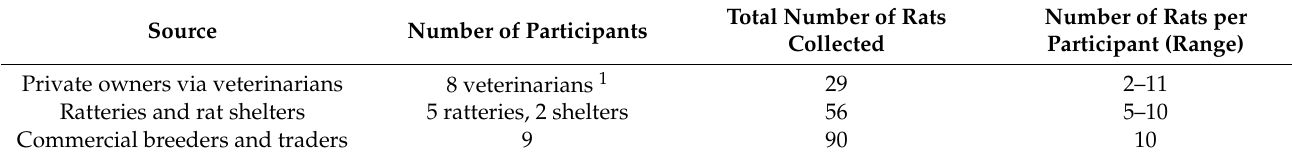
Table 1. Sources of rats collected for this study.